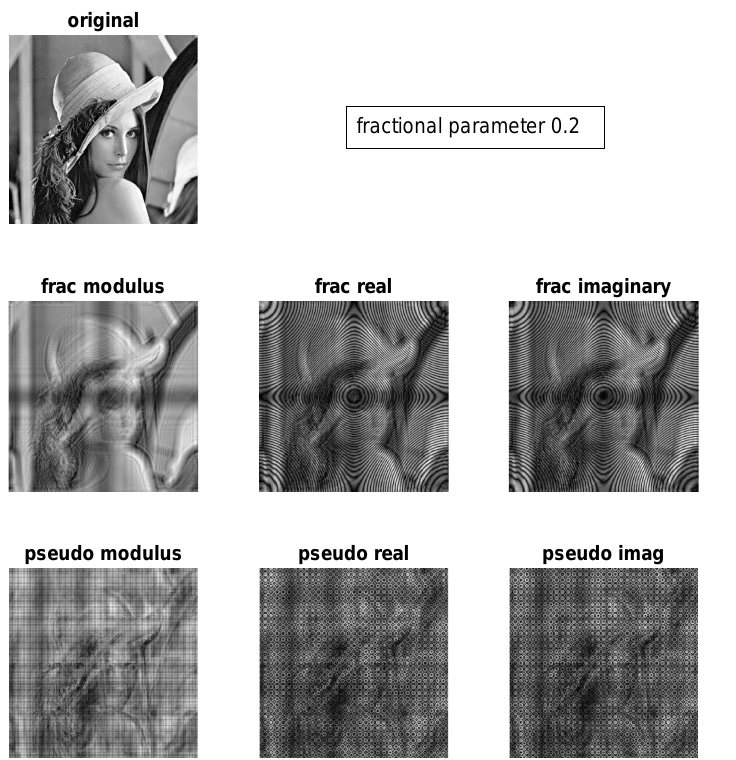
Figure 3. Comparison of DFrFT and DPFrFT of the grayscale image “Lena” for fractional parameter a = 0.2.